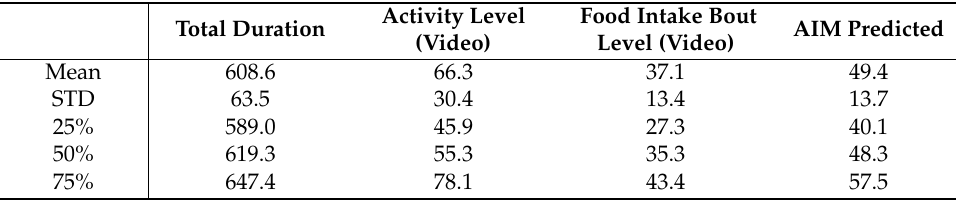
Table 5. Statistics on Duration of Experiments, Activity, and Food intake bout level eating duration and AIM predicted eating duration. All durations are in